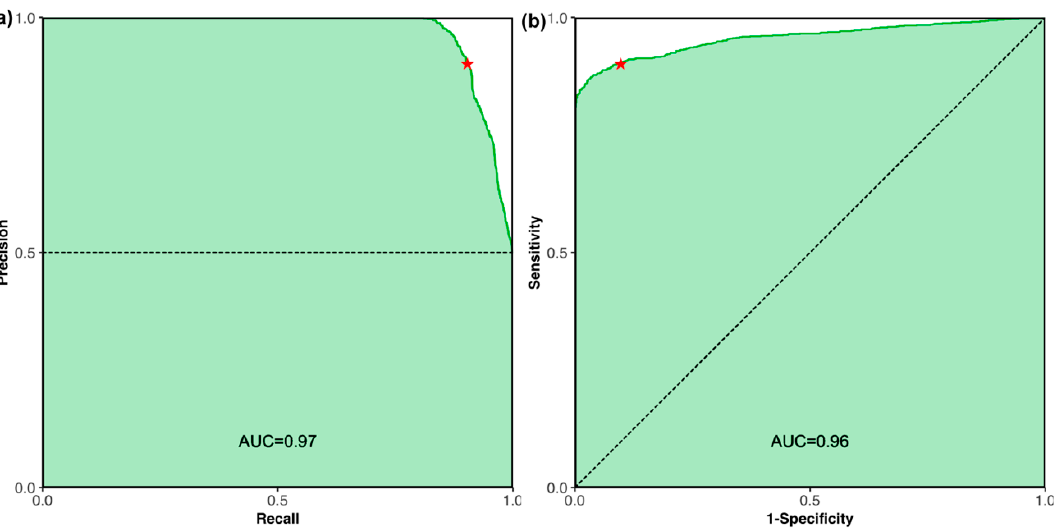
Figure 8. ML-based identification of kidney health using the signal intensity of the developed sensors. ( a , b ) illustrate the Precision-Recall and ROC curves with corresponding areas under the curves (AUC) of 0.97 and 0.96 when a SVM with linear kernel is used as the ML method under 5-fold cross-validation settings.